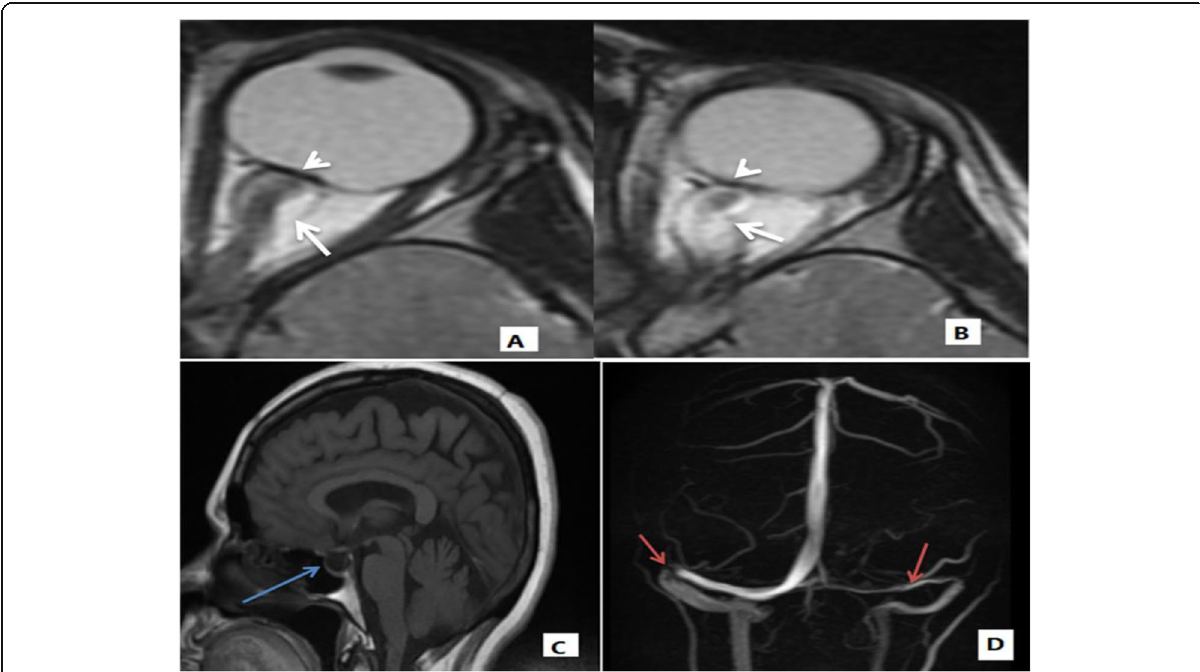
Fig. 1 a – d MRI and MRV of 37 years aged female patient diagnosed with idiopathic increase intracranial tension. a , b Axial T2 scan of left orbit shows tortuosity and grade 2 distention of left optic nerve sheath (white arrows) with flattened left posterior globe (arrowhead). c A mid-sagittal T1 MRI sellar cavity is enlarged with no detected pituitary gland inside grade 5 (empty sella) (blue arrow). d Time of flight MRV shows bilateral transverse sinus stenosis (the left transverse sinus is hypoplastic and also shows stenosis (red arrows)). Combined conduit score was 1 + 1 =